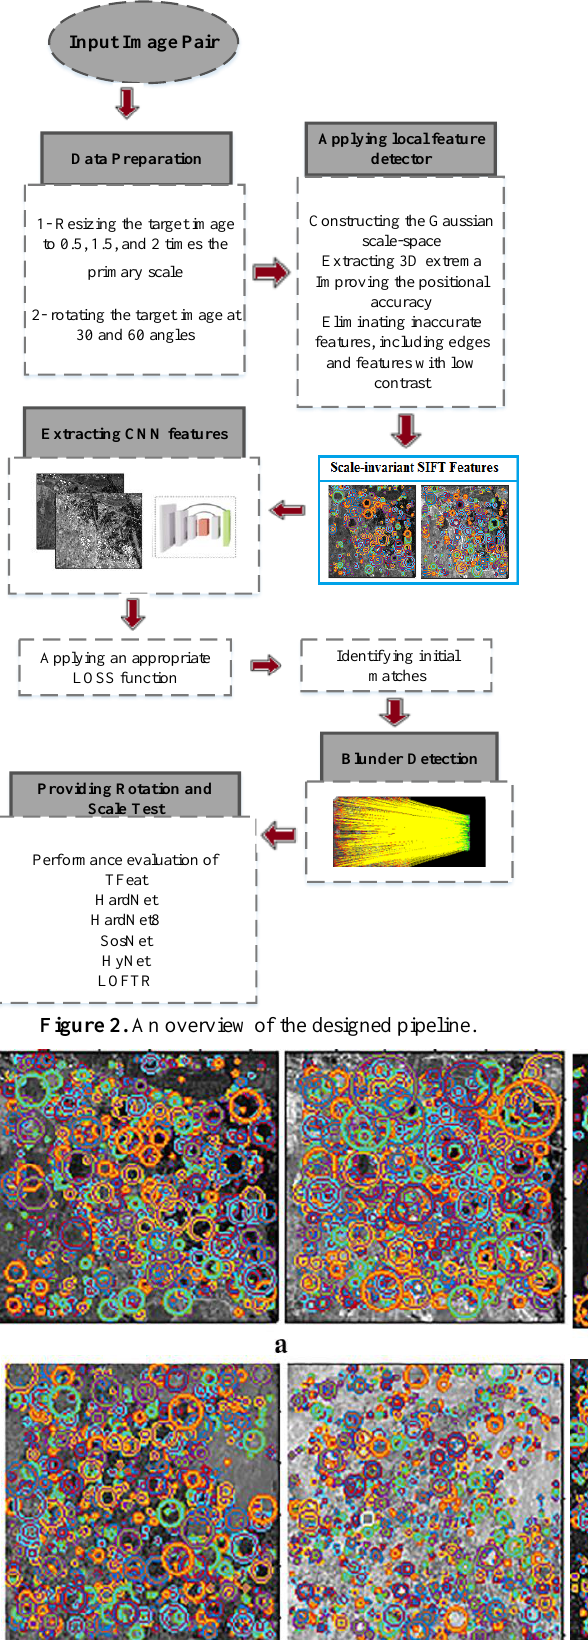
Figure 3 . extracted local features in various conditions within pairs a to